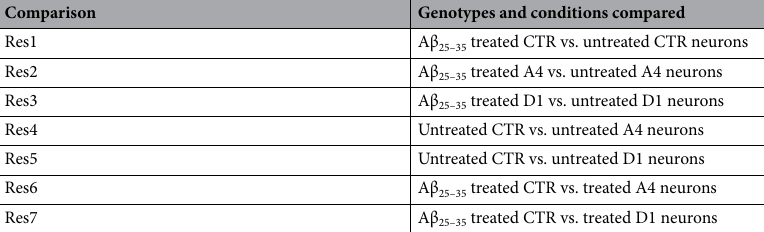
Table 1. A list of RNA-Seq comparisons. Differences in gene expression were analysed between CTR, A4 and D1 neurons, both in untreated and Aβ 25–35 treated neurons. The effect of Aβ 25–35 treatment on gene expression was examined in res 1–3 comparisons, while the effect of CLU exon 2 KO was examined in res